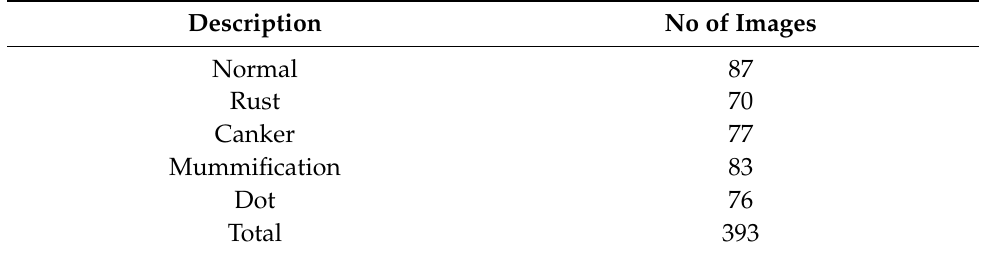
Table 4. Distribution of classes in the